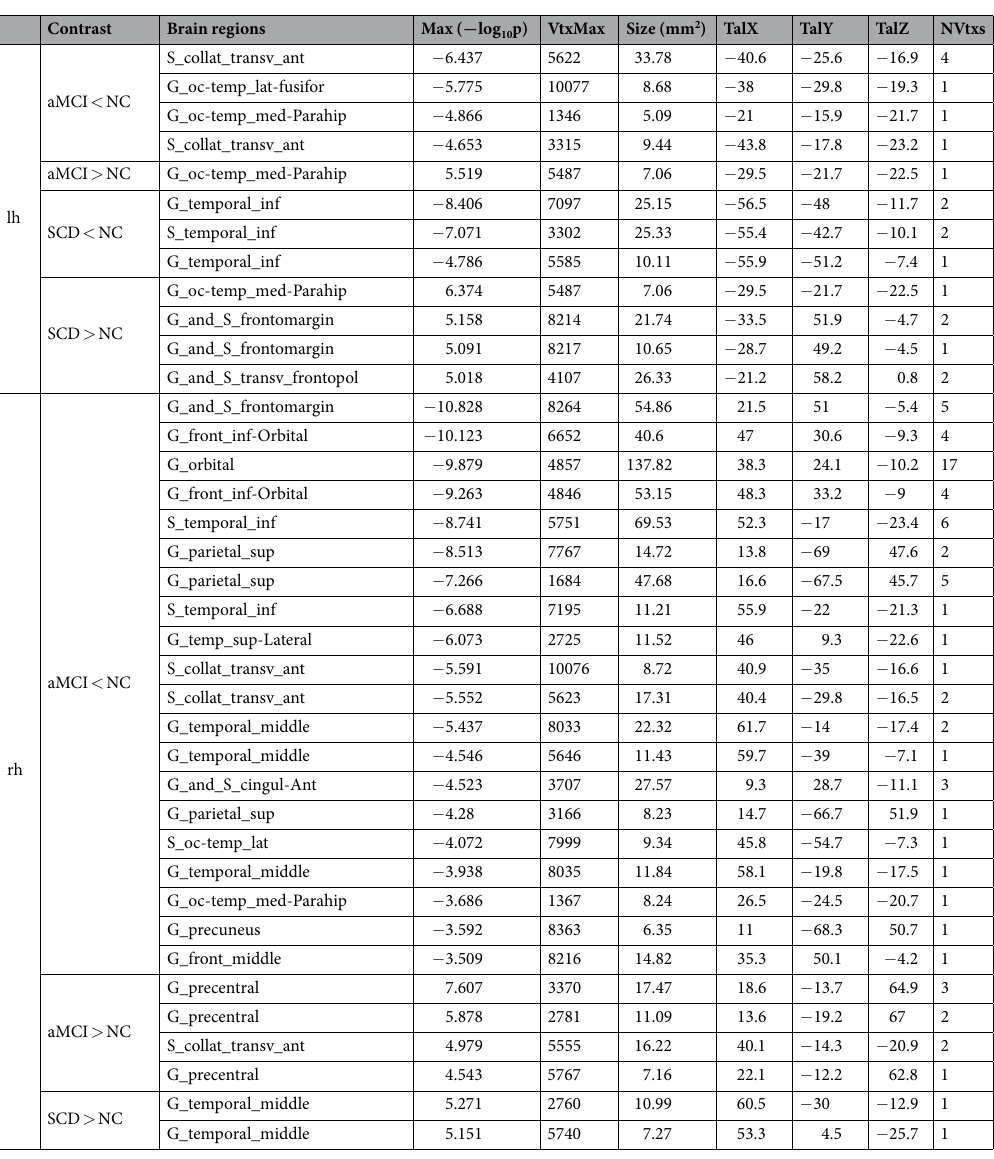
Table 1. Full list of brain regions with significant vIFC differences for aMCI-NC and SCD-NC. AD, Alzheimer’s Disease; aMCI, amnestic Mild cognitive impairment; SCD, subjective cognitive decline; NC, cognitively normal subjects; lh, left hemisphere; rh, right